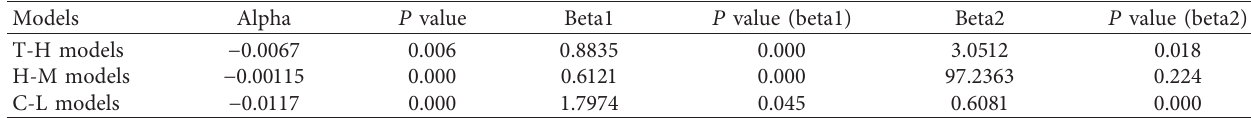
Table 2: Three regression models of linear regression